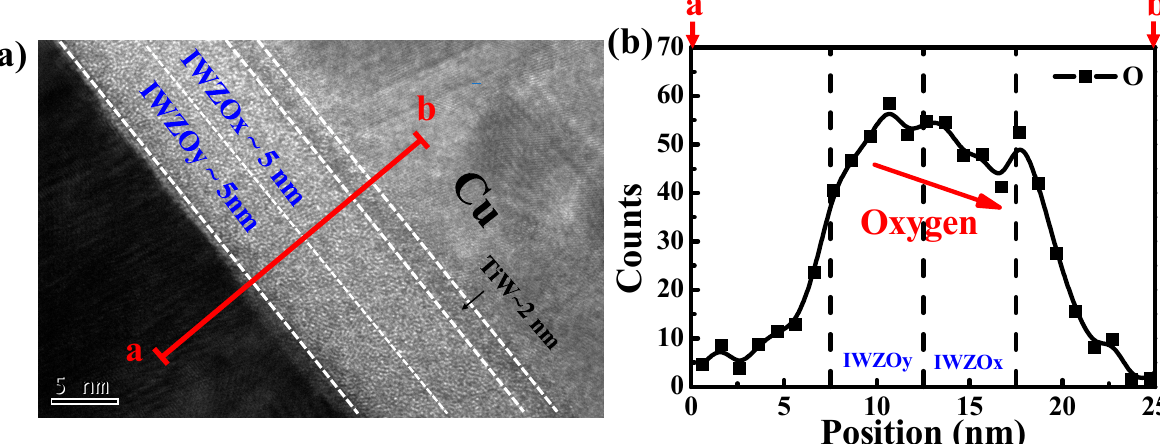
Figure 3. ( a ) The cross-sectional TEM image for a CBRAM device with a stacking IWZOx/IWZOy switching layer. ( b ) Line profile of the O element content along the red line in ( a ) for an IWZOx/IWZOy device.